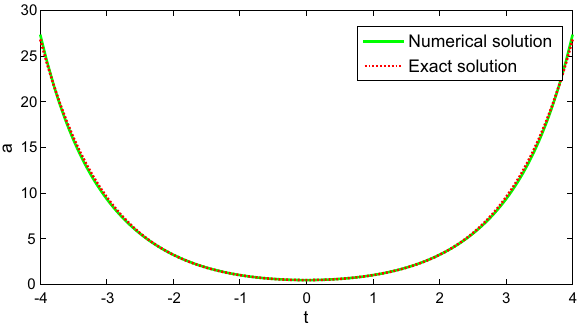
Fig. 10 Plot of a ( t ) obtained of Eq. (38) used V given by Eq. (37), as well as from the exact solution of Eq. (7), for the parameter values c = 0 . 5 and s =